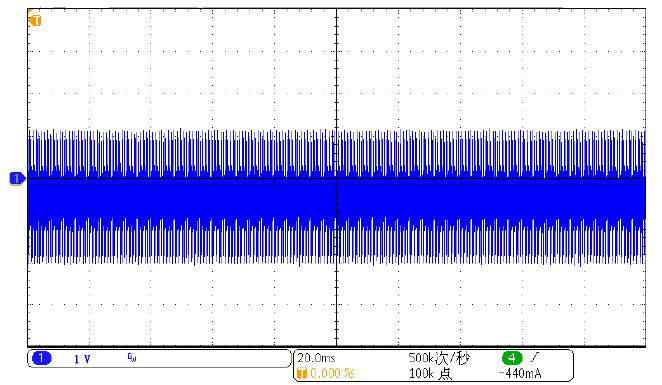
Figure 6. Class D signal supraharmonic voltage waveform.